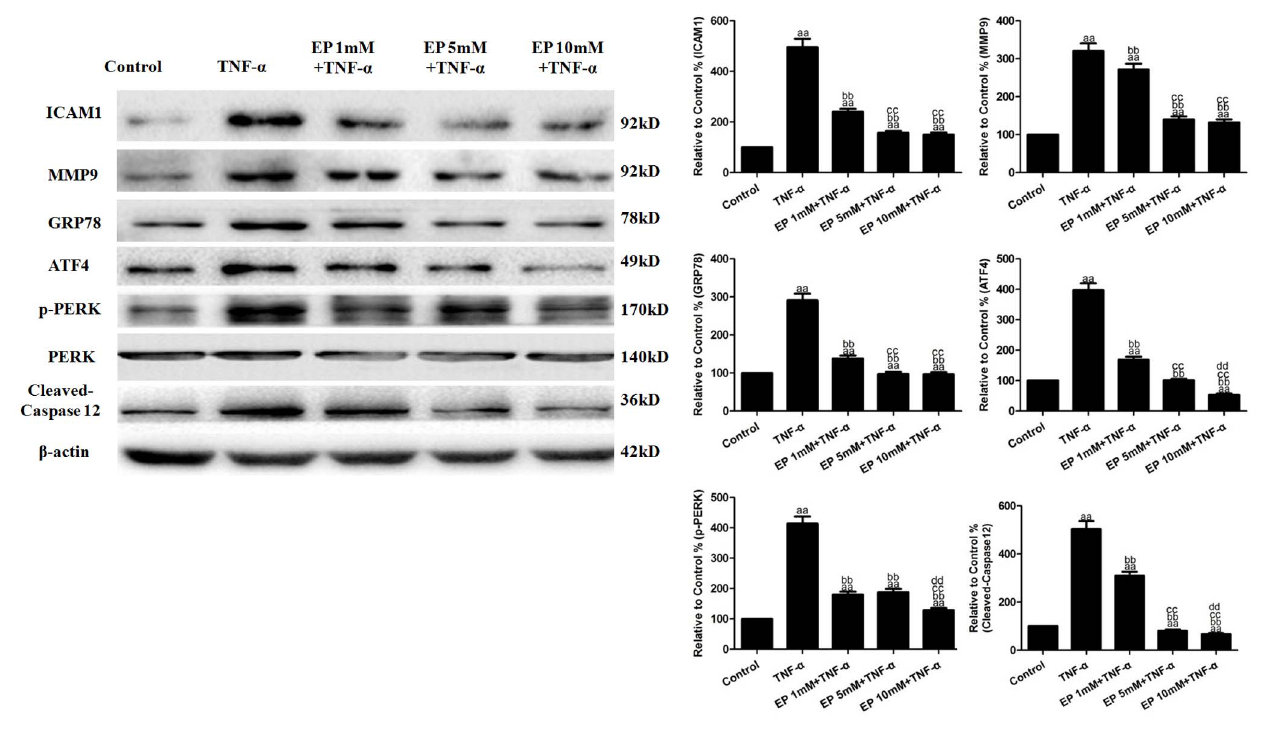
Figure 3. Effects of EP on the TNF- a -induced inflammatory protein and ERS-related molecules in HUVECs. Representative Western blot results showingICAM1, MMP9, GRP78, ATF4, cleaved-caspase12, p-PERK and PERK protein expression. The results are expressed as the means ¡ SD, n 5 6. aa P , 0.01, compared with the control group; bb P , 0.01, compared with the TNF- a group; cc P , 0.01, compared with the 1 mM EP + TNF- a group; dd P , 0.01, compared with the 5 mM EP + TNF- a group. EP, ethyl pyruvate.